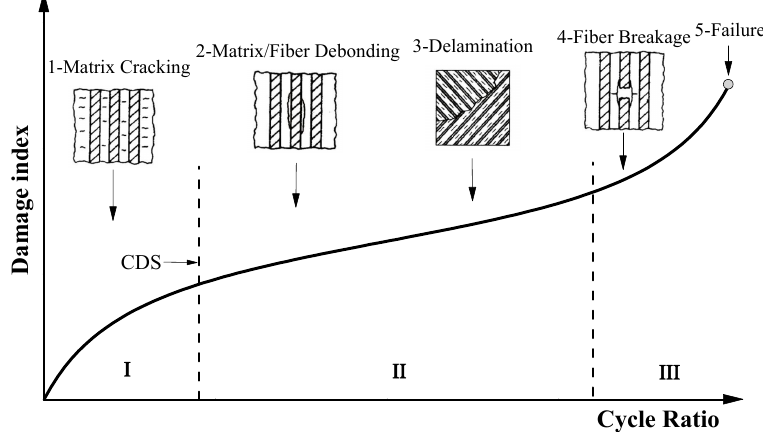
Figure 3. Schematic fatigue damage evolution of the FRP composite.